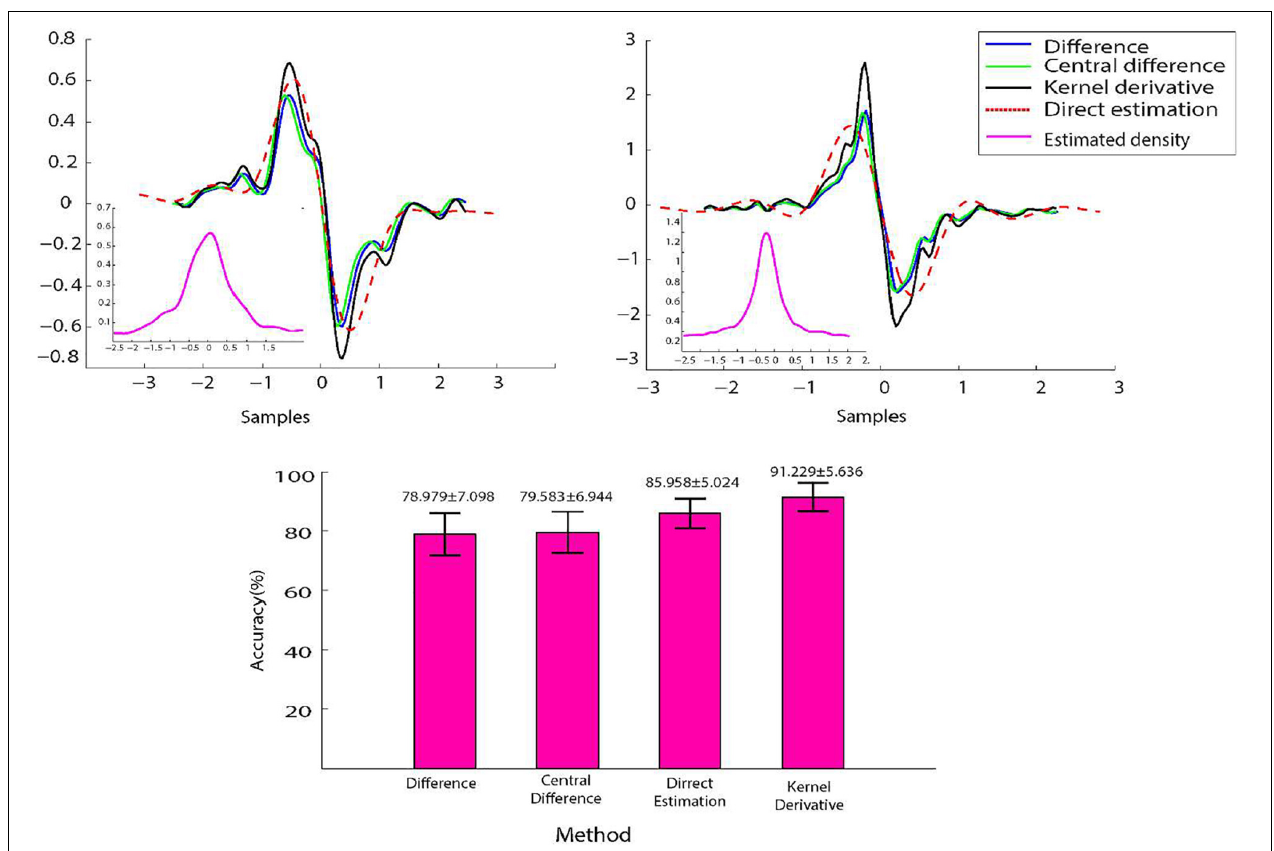
FIGURE 4 | The effect of different methods of estimating the kernel density derivative on the overall performance of classification. Upper panel represents the kernel density and its derivatives estimated using four methods (basic difference, central difference, kernel derivative, and direct kernel derivative) on a signal for the movements no. Twenty (left) and 13 (right). Lower panel shoes the overall classification performance of the linear discriminant analysis (LDA) classifier with trimmed mean absolute value of derivative density (TMAVDD) feature when derivative of estimated density was calculated using those four